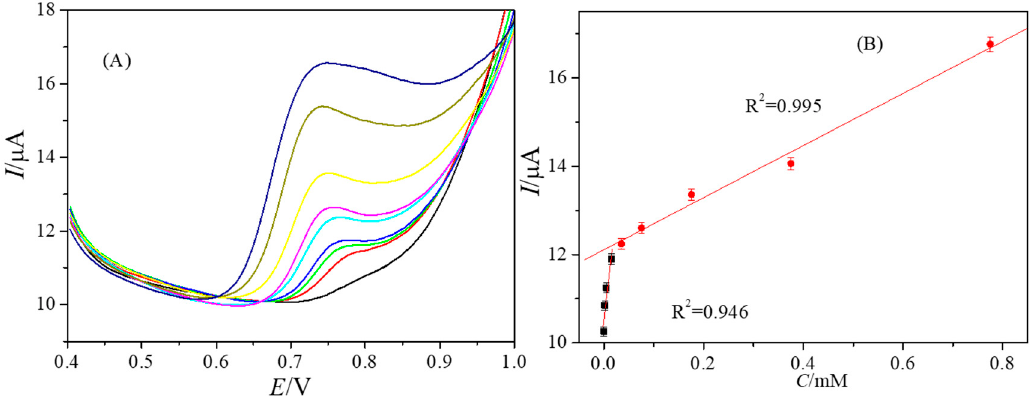
Figure 5. DPVs of PtNPs@GDY/GCE in 0.1 M PB (pH 6.0) with different concentrations of BPAF